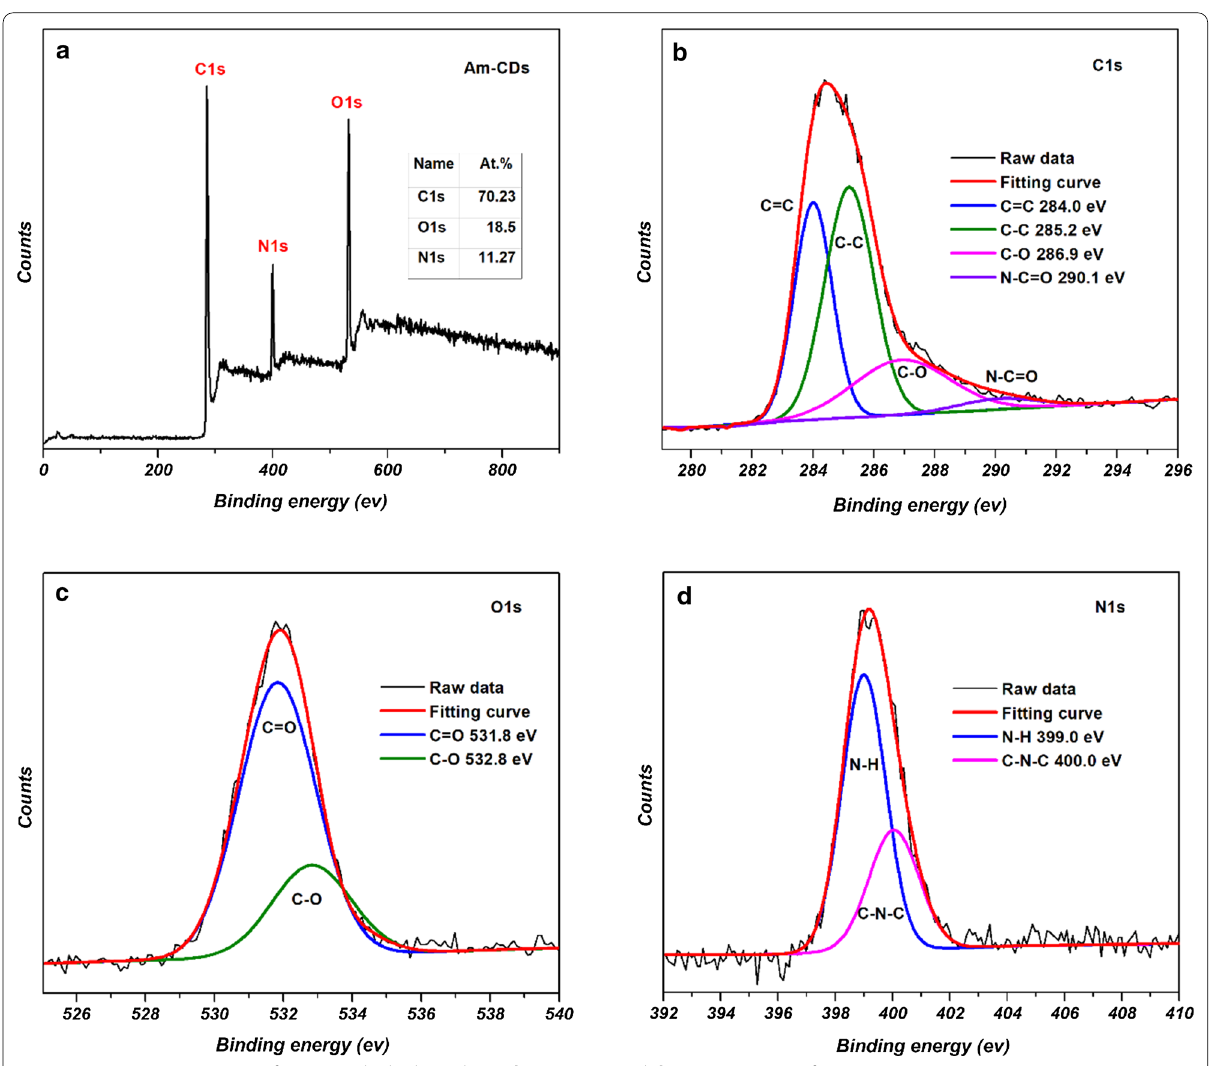
Table 1 The elemental compositions of A x -CDs